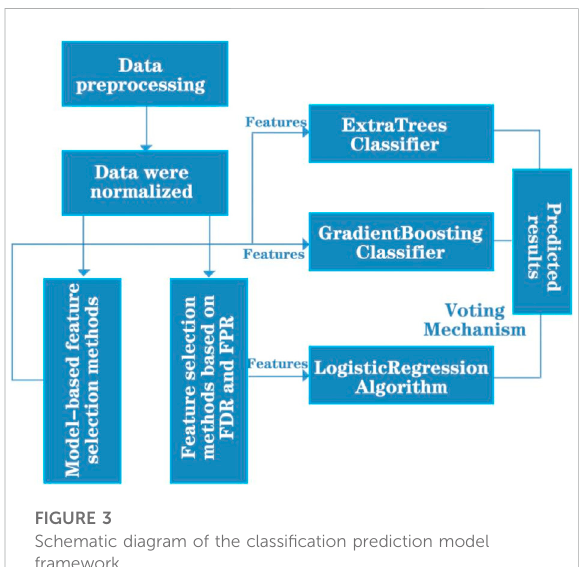
FIGURE 3 Schematic diagram of the classi fi cation prediction model framework.